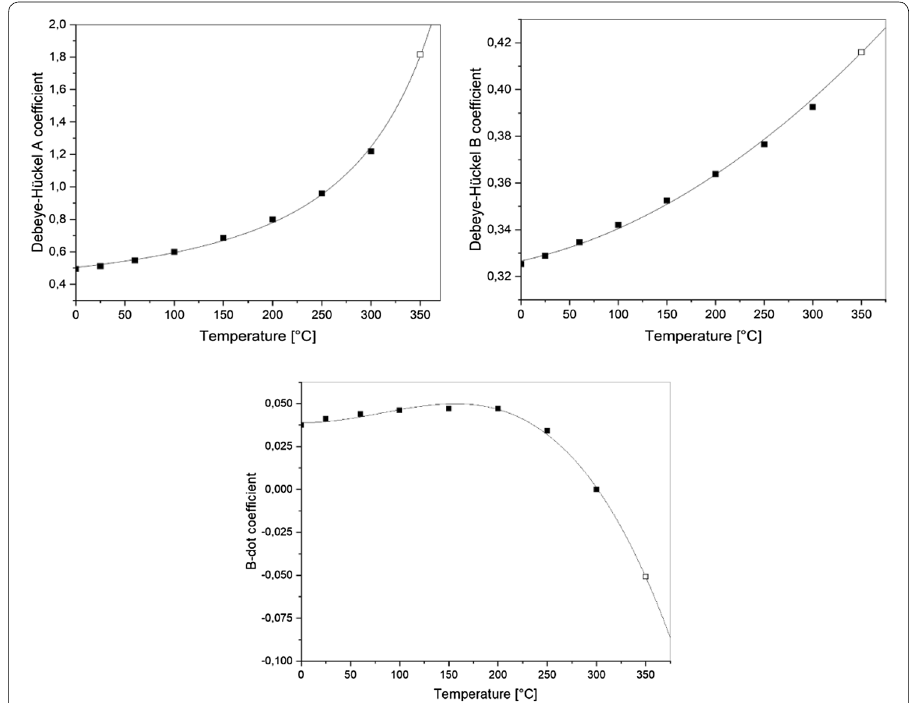
Fig. 8 Extrapolation of the three parameters A, B, and Ḃ of the extended Debye–Hückel equation for temperatures beyond 300 °C. The values of the solid squares are acquired from the LLNL database in IPhreeqc. The hollowed squares are the results of a polynomial fit